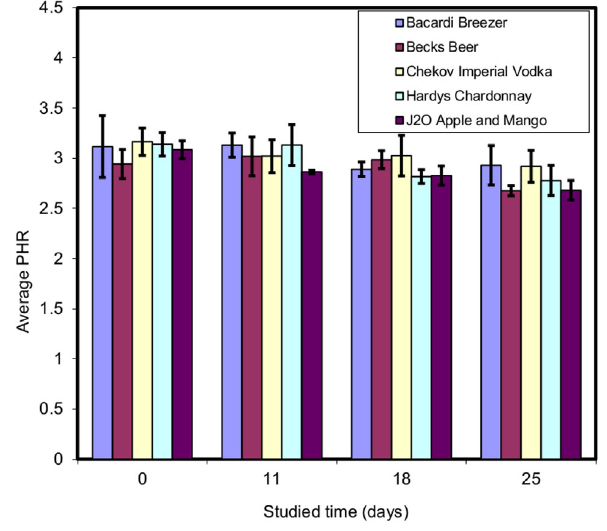
Figure 1. Peak height ratio (PHR) of diazepam: diazepam -d 5